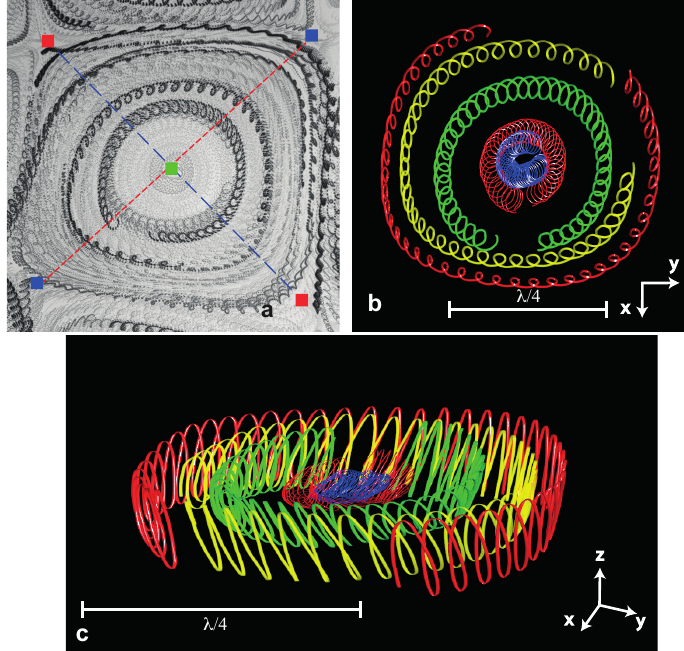
Figure 7. ( a ) Experimentally measured trajectories of particles tracked for ∼ 40 periods, within a unit cell. The green square in the middle shows the position of the nodal point. The wave peak and trough are shown as red squares, and the blue squares show the position of the saddle points. Reconstructed 3D trajectories shown in the ( b ) top view (orthogonal projection), and ( c ) side view (perspective view). Experimental parameters: f = 3.8 Hz, λ = 104 mm, φ = 90 ◦ , video acquisition rate is 55